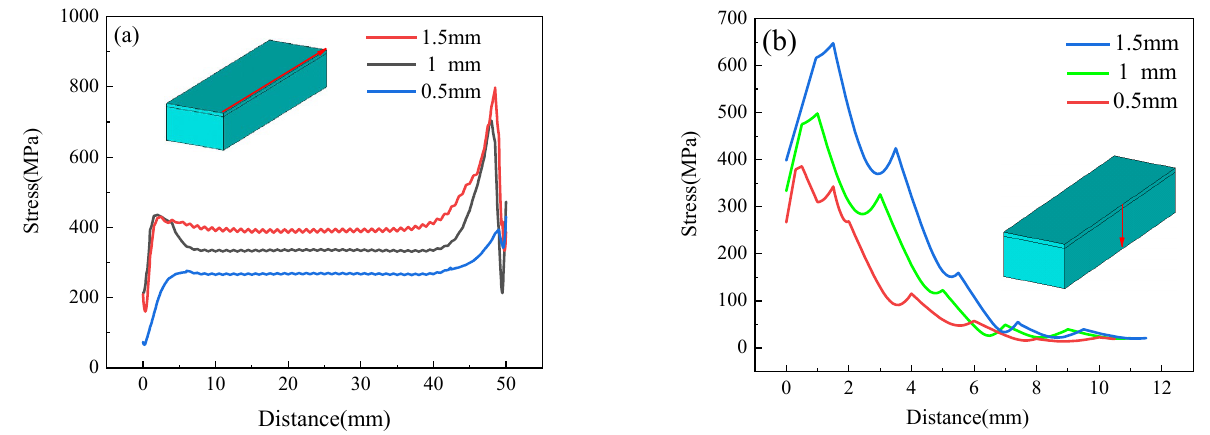
Figure 7. Residual stress distribution on different paths for different coating thicknesses: ( a ) residual stress distribution on the scan centerline; ( b ) residual stress distribution in the depth direction.